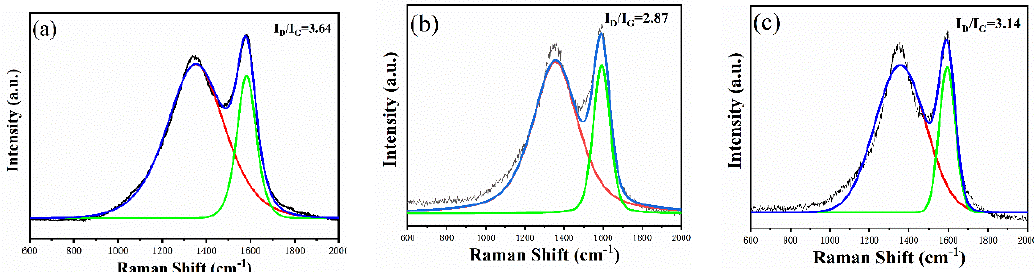
Figure 14. The char residue from EP examined using Raman spectroscopy. ( a ), EP/7.5MBR@LDHP-